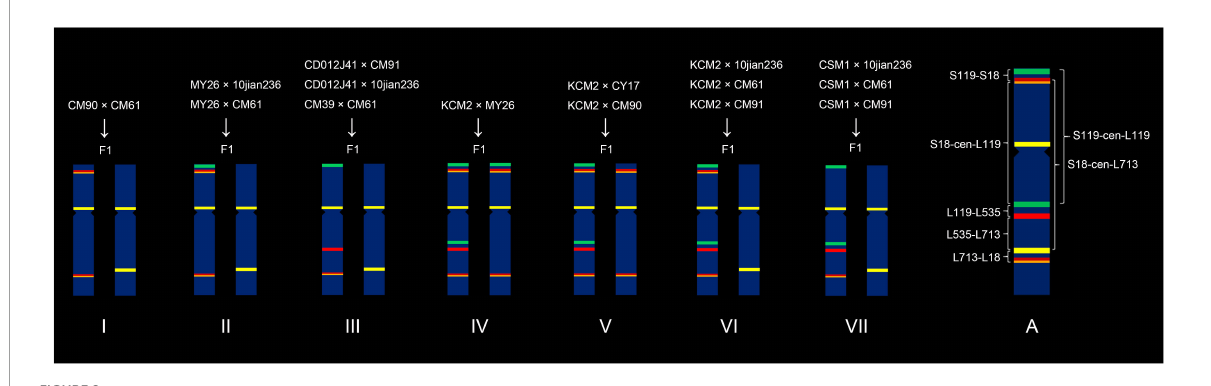
FIGURE2 Seven categories of combination of 5A chromosomes in F 1 generation plants. “F1” indicates F 1 generation. (A) Scheme of recombination